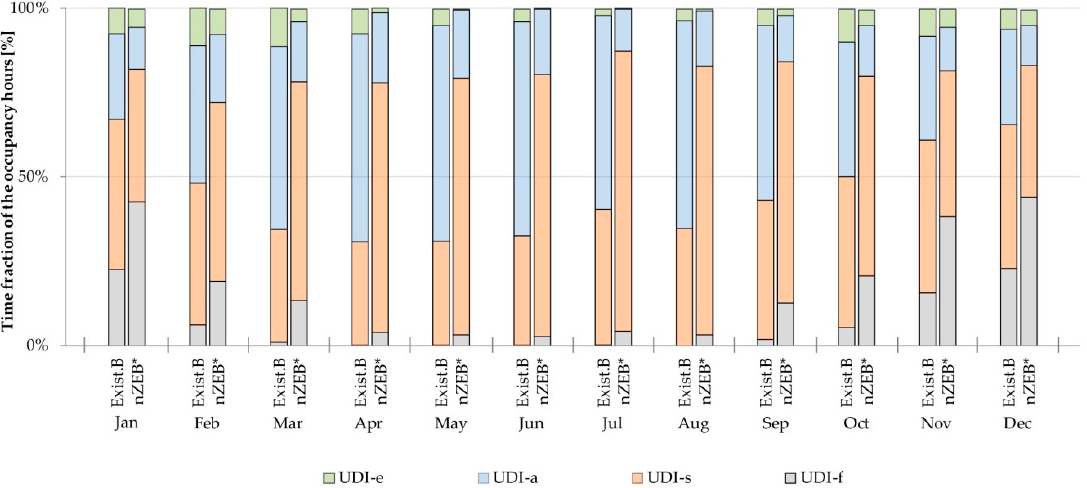
Figure 7. Comparison of the UDI levels for the occupied hours over the whole year between the building in the present configuration (Exist.B) and after the retrofitting of the building envelope (nZEB*) on a monthly basis. Table 6. Comparison of UDI -f, UDI -s, UDI -a and UDI -e between the building in the current condition (Exist.B) and after the retrofitting of the building envelope (nZEB*) for the North and South-oriented offices, on an annual basis.